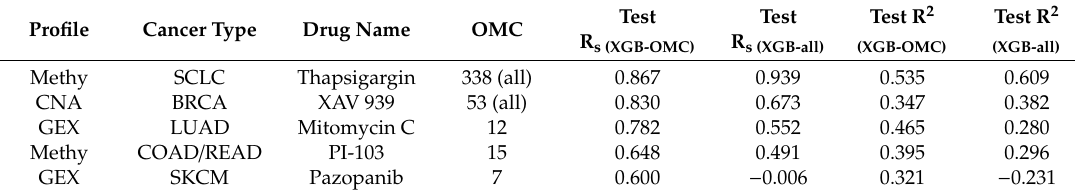
Table 1. The most predictive XGB-OMC models per cancer type. Optimal complexity, test set performance (Spearman), and the test set performance (Spearman) of the corresponding all features models are shown (BRCA: breast invasive carcinoma, COAD / READ: colon adenocarcinoma / rectum adenocarcinoma, LUAD: lung adenocarcinoma, SCLC: small cell lung cancer, SKCM: skin cutaneous melanoma). For each of these models, validation set performance also exceeded Rs > 0.25 in all validation